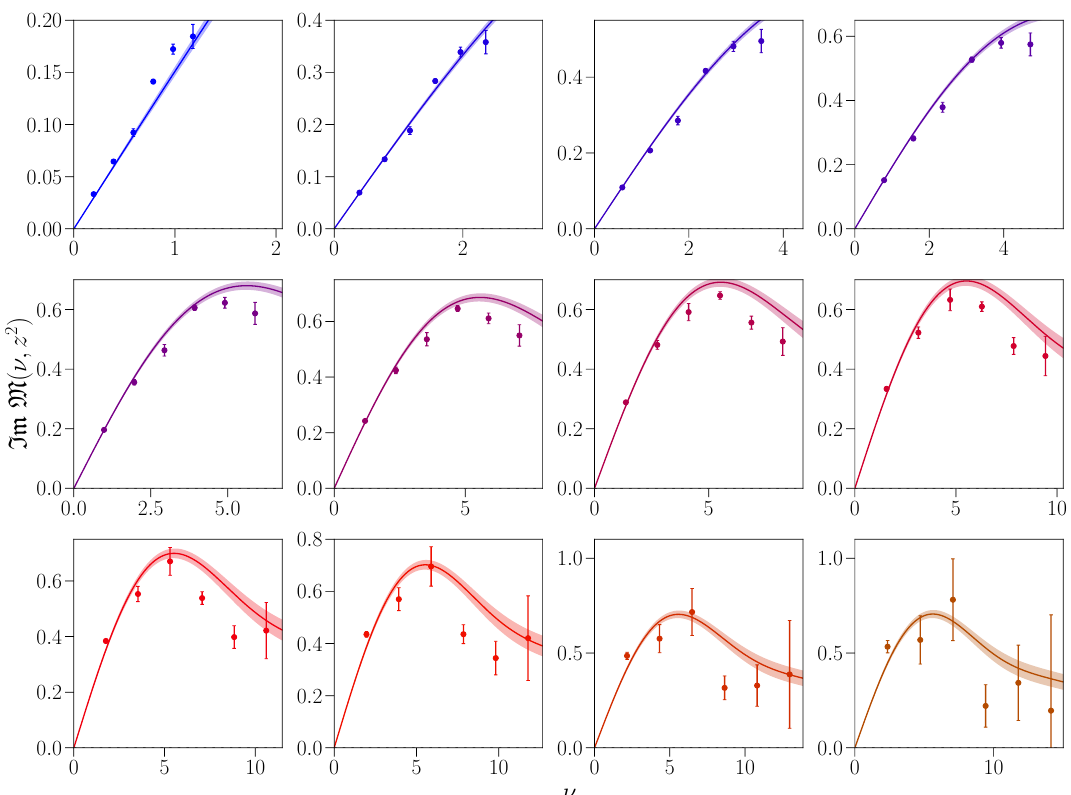
Figure 16. Fit to the imaginary component of the unpolarized reduced pseudo-ITD where the leading-twist, discretization, twist- 4 , and twist- 6 corrections have been expanded in Jacobi polynomials up to order { n = { 3 , 3 , 1 , 0 } . Starting from the upper left panel and lt , n az , n t 4 , n t 6 } + + traversing horizontally, the leading-twist plus corrections are shown for each z/a ≤ 12